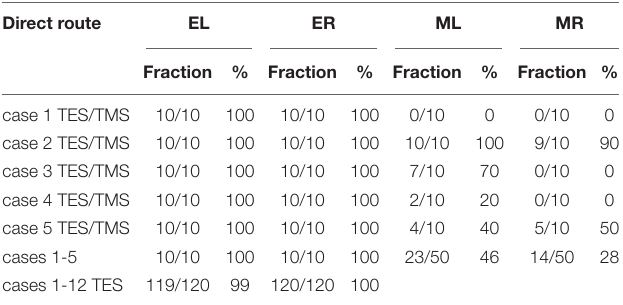
TABLE 1 | Overview of fractions of the number of left and right latency times EL and ER for TES and ML and MR for TMS allocated to the direct route related to the total number of stimulations (10 per case) when using < 18.5 ms as selection criterion for TMS latencies according to the SAN time windows in Figure 3 .